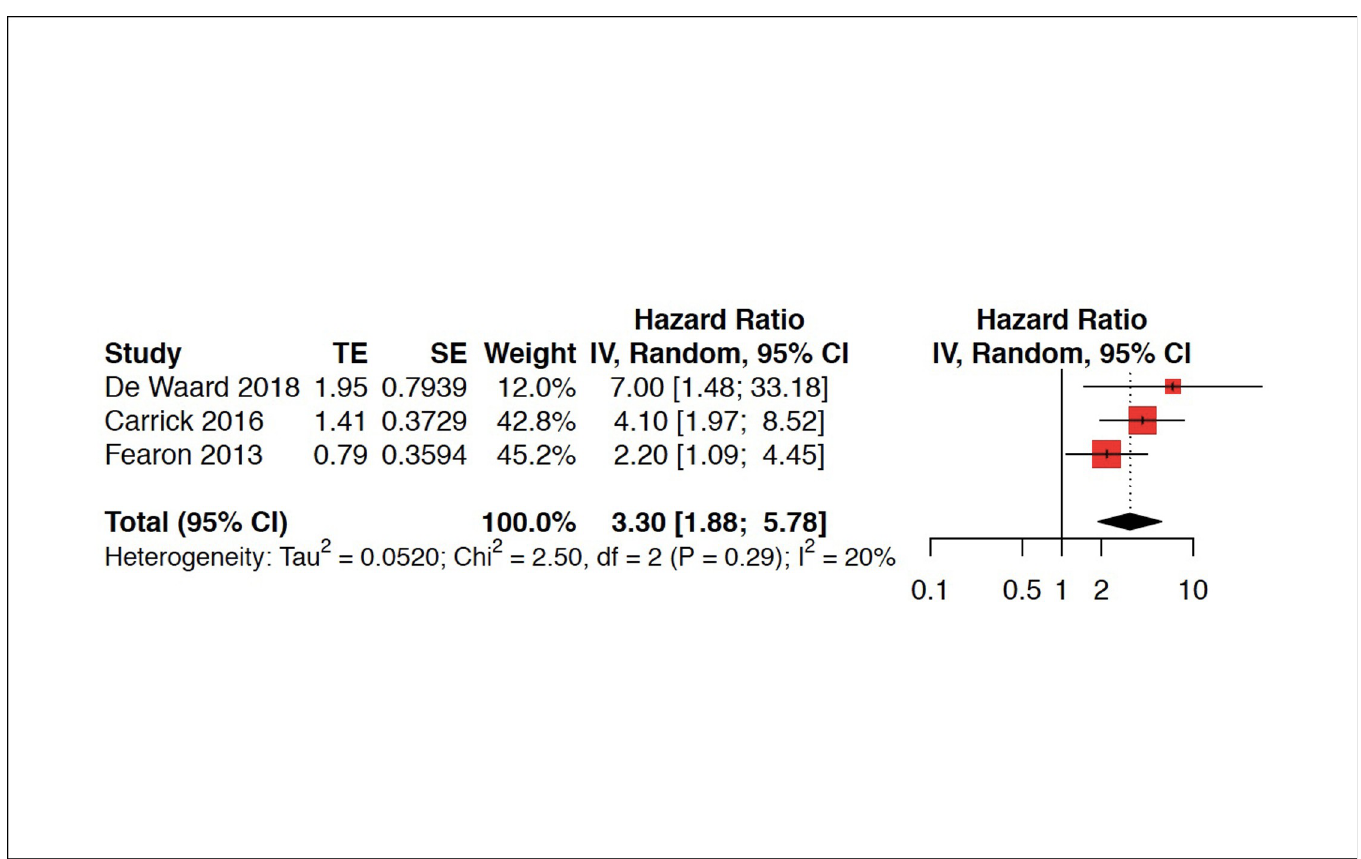
Fig 4. Sensitivity analyses. Sensitivity analyses consisted in repeating the forest plot after removing 3 studies at high risk of bias.